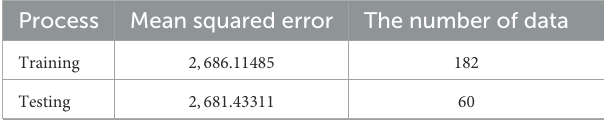
TABLE 7 Iteration summary for training and testing